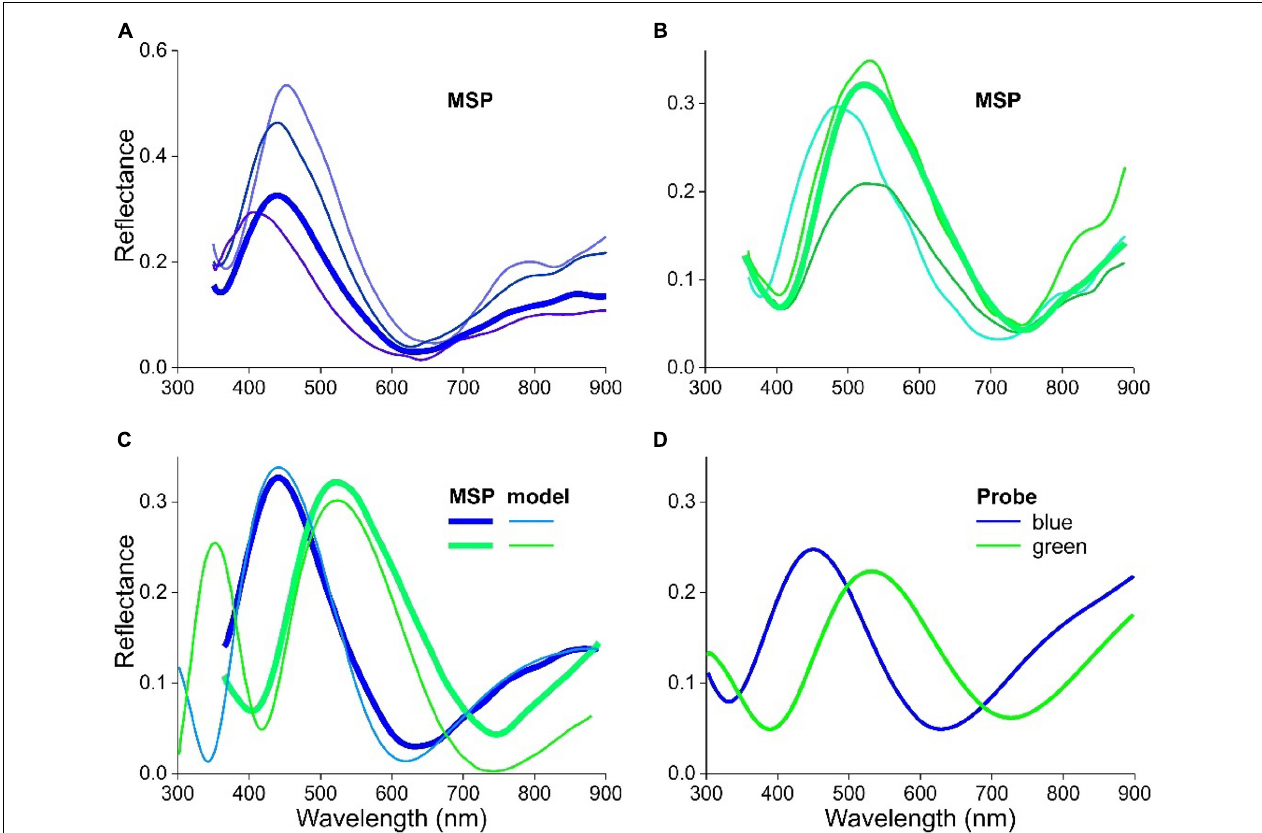
FIGURE 8 | Reflectance spectra of feathers and barbules of L. nitens . (A) Spectra of a tail feather measured with a microspectrophotometer. (B) Spectra of a covert feather measured with a microspectrophotometer. (C) An MSP spectrum of (A) compared with a modeled spectrum for a barbule with cortex thickness c = 135 nm (blue) and an MSP spectrum of (B) compared with a modeled spectrum for a barbule with cortex thickness c = 188 nm (green). (D) Spectra of a tail (blue) and covert (green) feather measured with a bifurcated